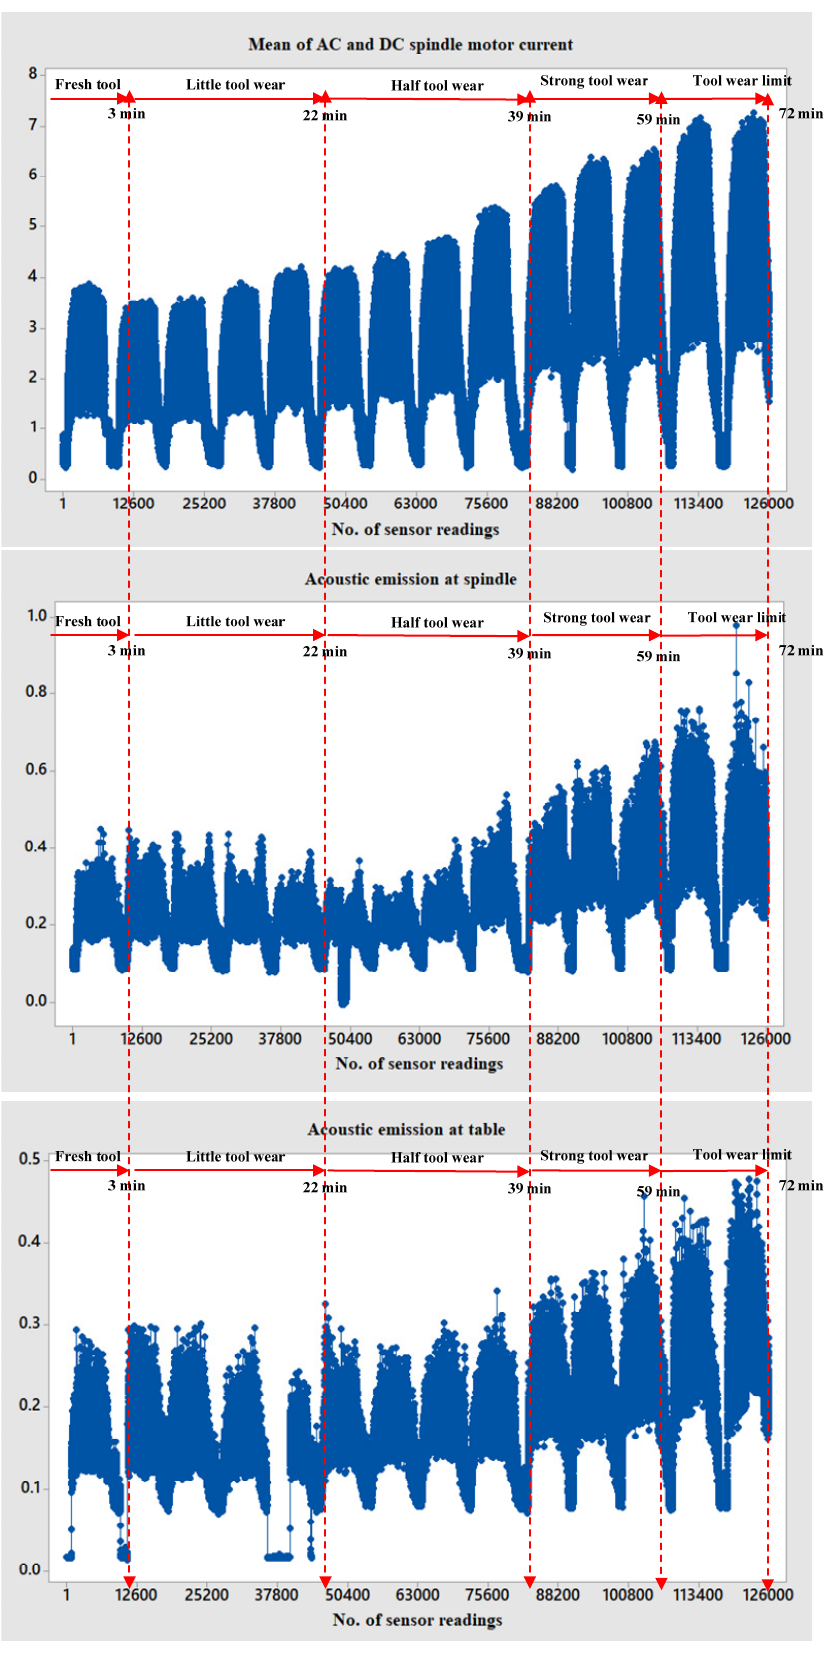
Figure 7. Sensor-gathered data for monitoring tool wear status for the GUI shown in Figure 6.